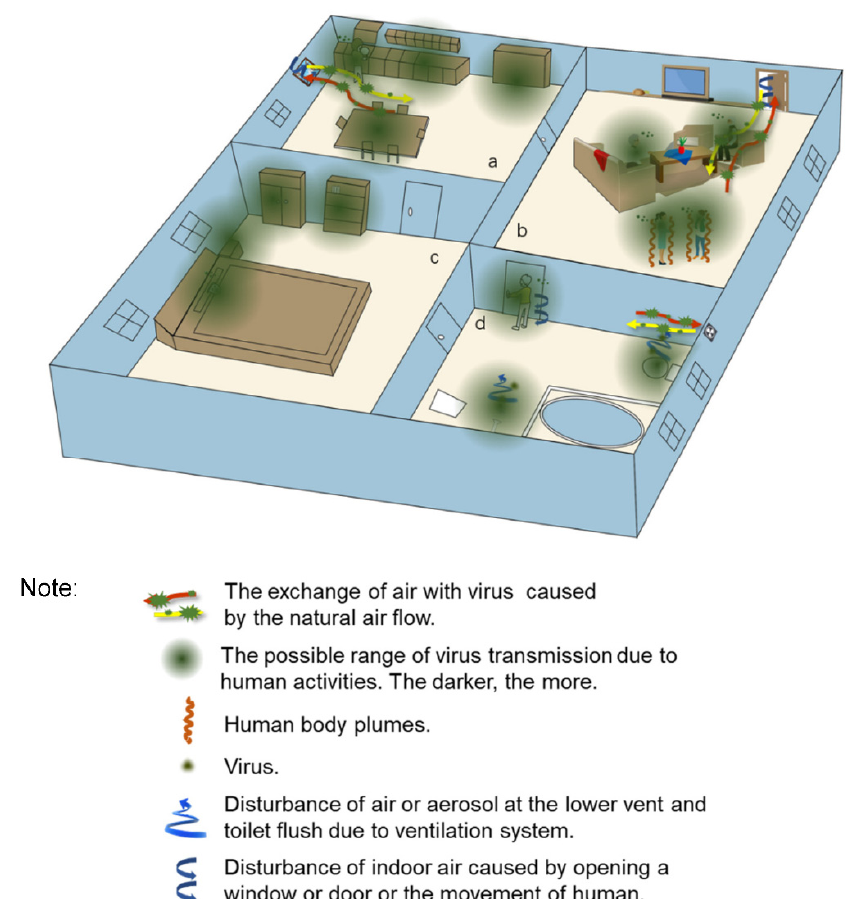
Figure 3. People’s different behaviors in different parts of the family may be ways of spreading the virus. ( a ) Cooking and eating in the kitchen; ( b ) Chatting in the living room; ( c ) Sleeping in the bedroom; ( d ) Washing, bathing, and using the toilet in the bathroom. Ventilation system and heating system of the home, and the movements of doors, windows, and people drive the flow of indoor air, and the virus also spreads. The body thermal plume creates a thin layer of turbulence around the body, and entrains and transports pollutants around the human body. Table 1. The virus survival time (d) on different textures in indoor